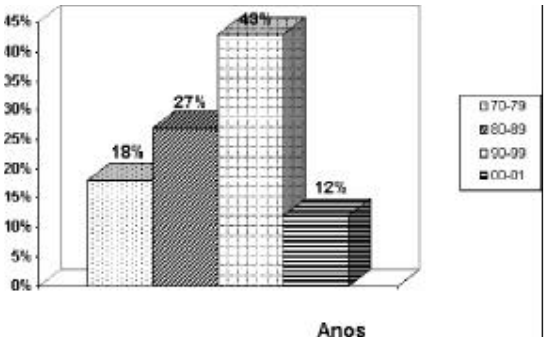
FIGURA 1- Distribuição das Cirurgiãs-dentistas, segundo a época de formatura. Araçatuba, SP-2002.